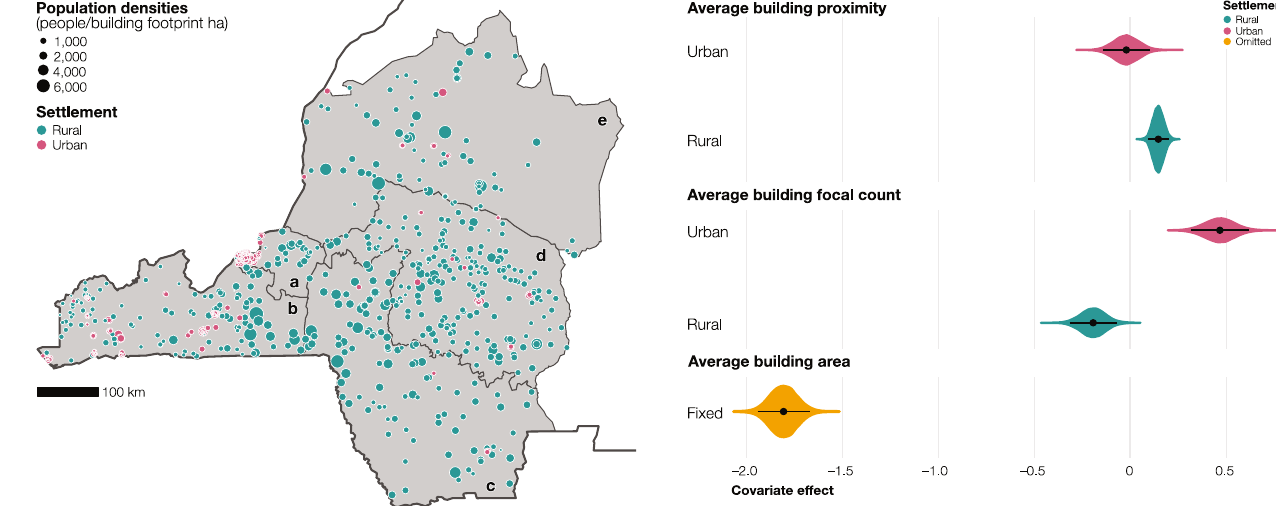
Fig. 4 Covariates effect. Posterior probability distribution of the random effect by settlement type (urban in pink and rural in purple) for the covariates average building proximity and average building focal count and the fi xed effect (in orange) for the covariate average building area. The black dots show the mean of the distributions and the horizontal black lines show the 95% credible intervals derived from the posterior distribution ( n = 10,000). Source data are provided with this